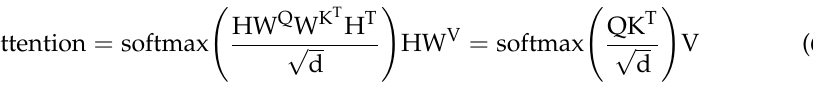
Figure 2. Calculation process of self-attention for To be specific, given query vector q i ∈ Q = [ q 1 , q 2 , . . . , q n ] and key vector k i ∈ K = [ k 1 , k 2 , . . . , k n ] . Firstly, the similarity α i , j = q i k j / computed by the scaled dot product function. The similarity score is divided by stable gradients, and the weight coefficient α i . j is computed by the softmax function. After that, a weighted summation operation is performed on each value v i ∈ V = [ v 1 , v 2 , . . . , v n ] to obtain the final attention a i = ∑ j α i , j v j according to weighted coefficients α i . j